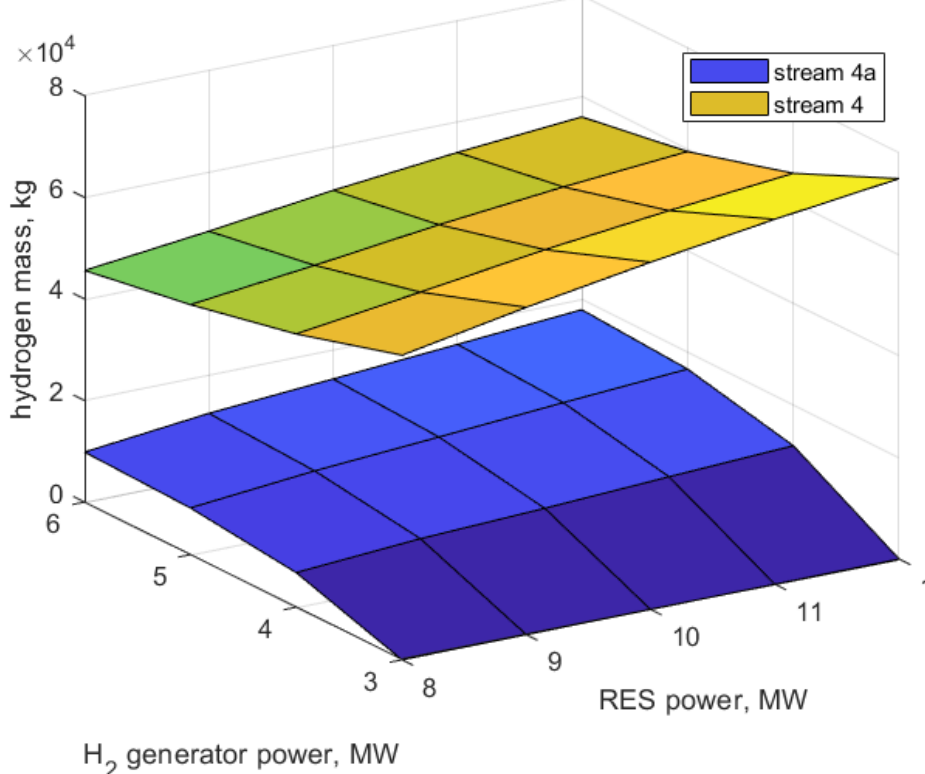
Figure 7. 3D graph depicting the quantity of hydrogen directed through either line 4 and 4a, for a one-year operation, as a function of the variable power of the RES and hydrogen generator.